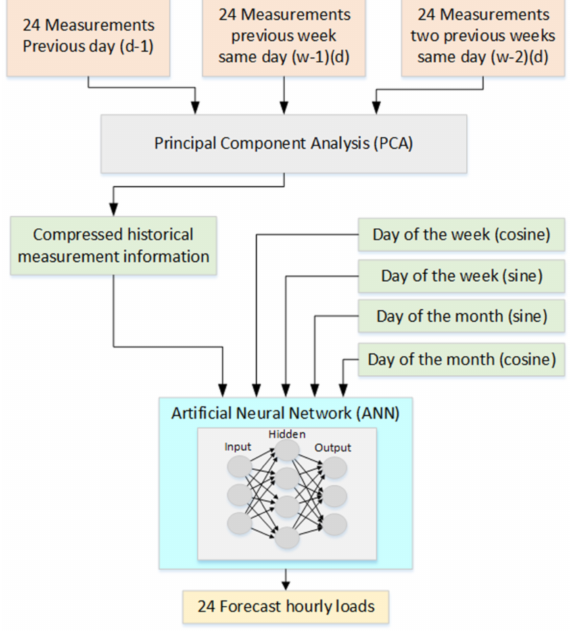
Figure 2. Functional diagram of the load forecasting